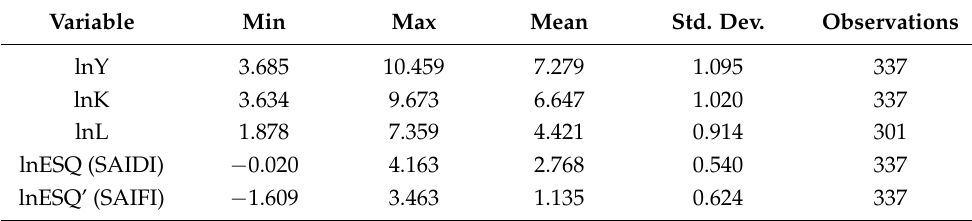
Table 2. Summary statistics.